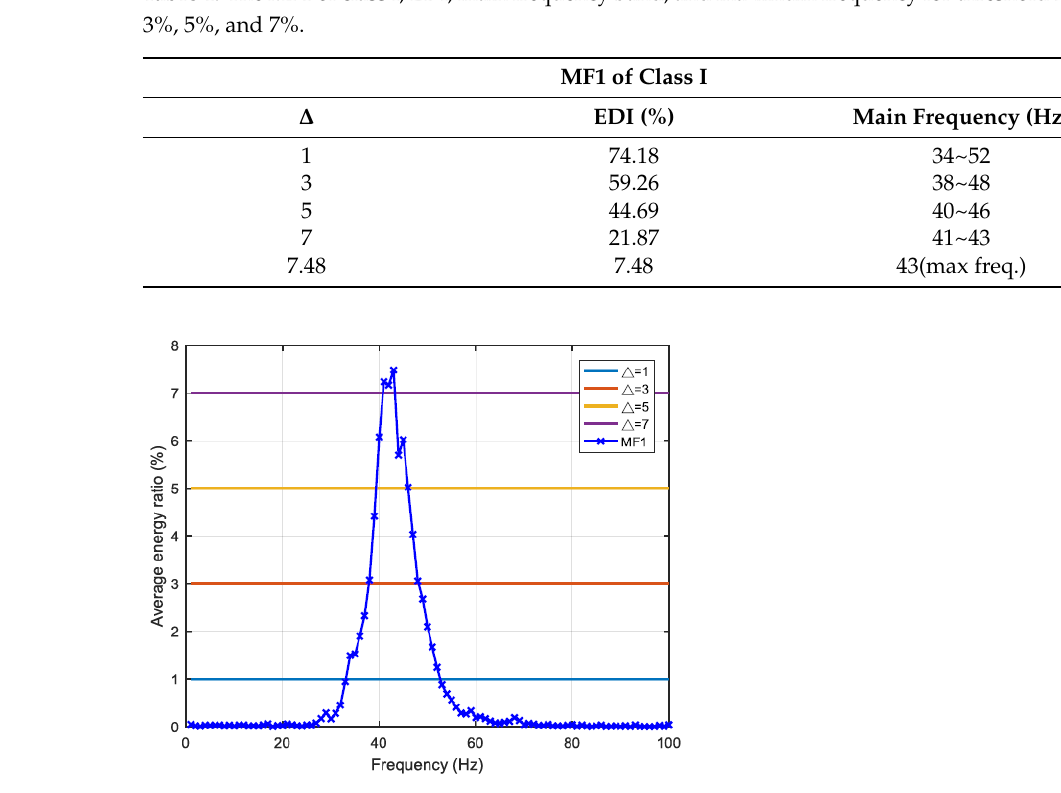
Figure 6. MF1 of class I average frequency – energy distribution.